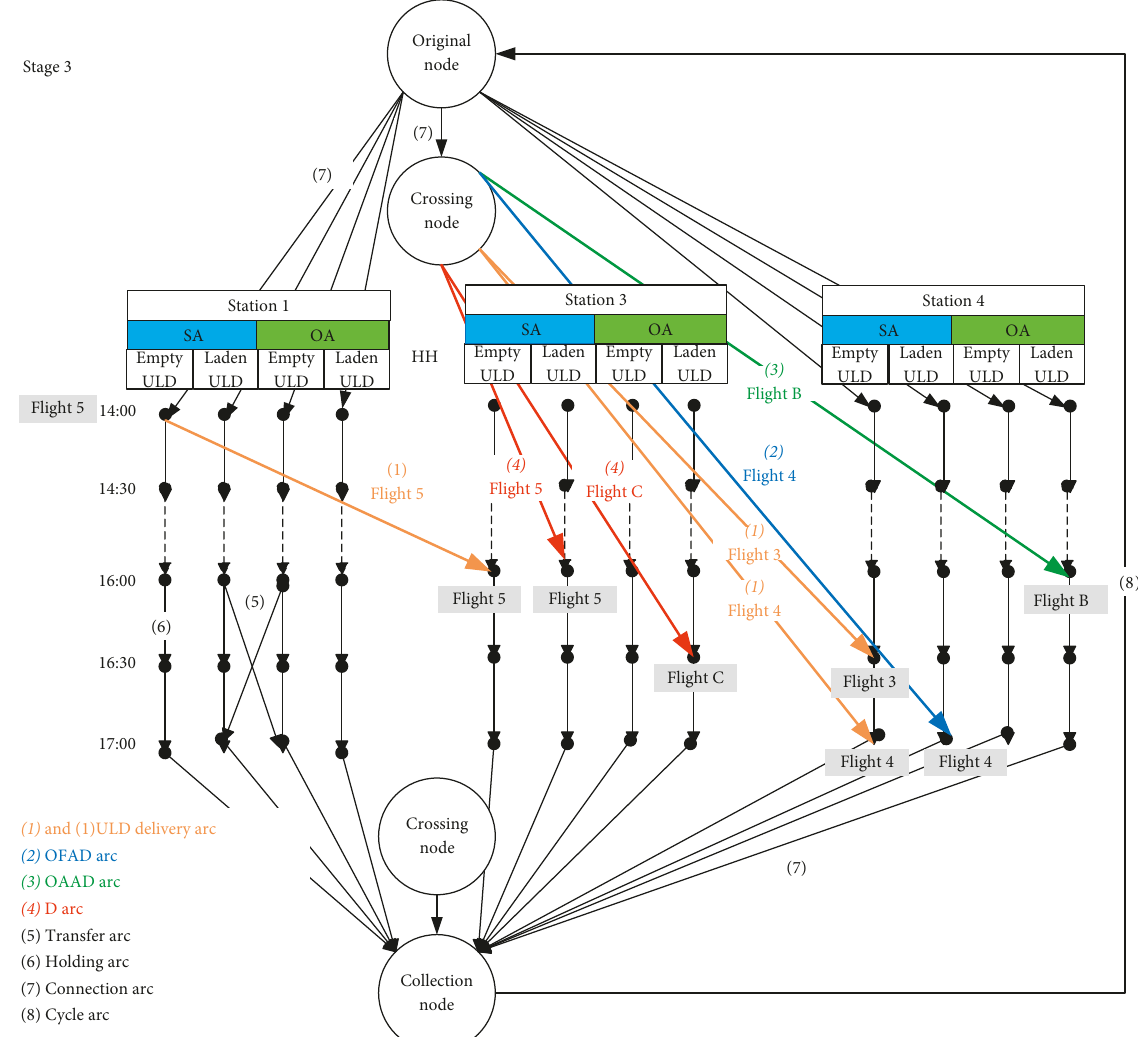
Figure 8: Self-owned ULD network for stage Figure 7. We design OAAD arc (3) for flight A connecting from the node in the laden ULD group on the OA side for flight 1 with an 08:00 departure time from station 1 to a node in the laden ULD group on the OA side for flight A with an arrival time of 10:30 at station 3. (b) Flight across stages Suppose that flight B aids flight 3 to deliver laden ULDs (OD 1 ⟶ 4) across stages 1 to 3. There are two OAAD arcs for flight B in the two networks An OAAD arc represents the OAAD_ULD redis- for stages 1 and 3. patch method, which connects nodes on the OA sides indicating ULD deliveries by other airlines. The OAAD arc for a flight is set depending on whether the flight is within or across stages.